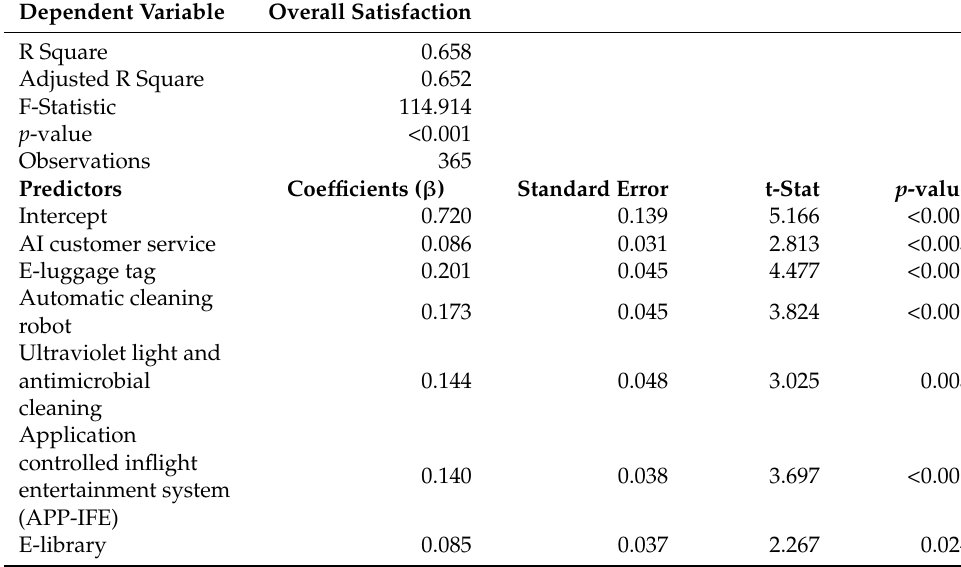
Table 3. Results of multiple linear